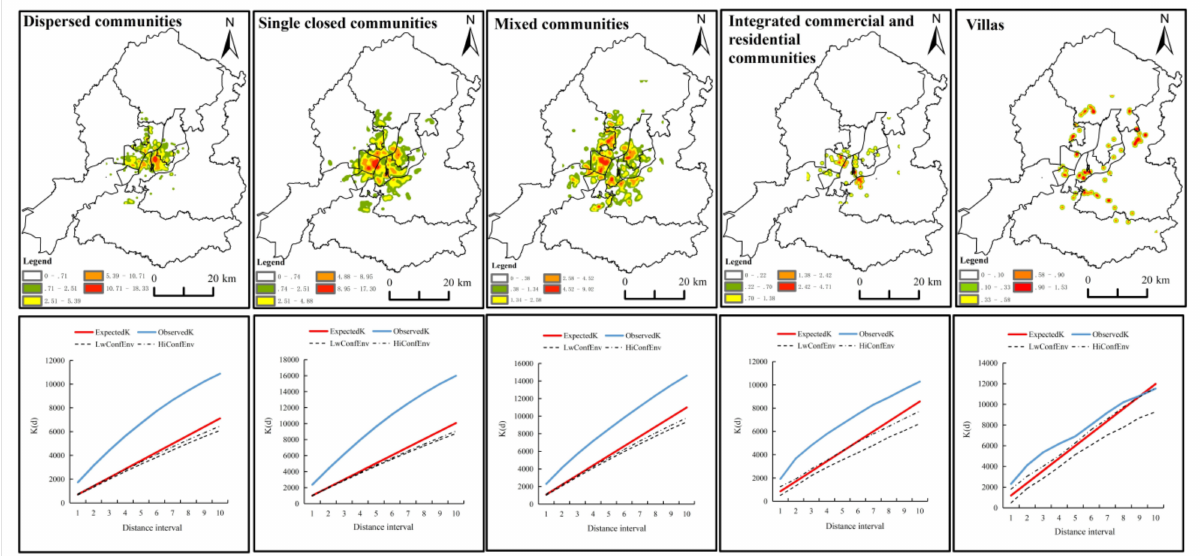
Figure 6. Nuclear density distribution and multi-distance spatial cluster diagram of all kinds of